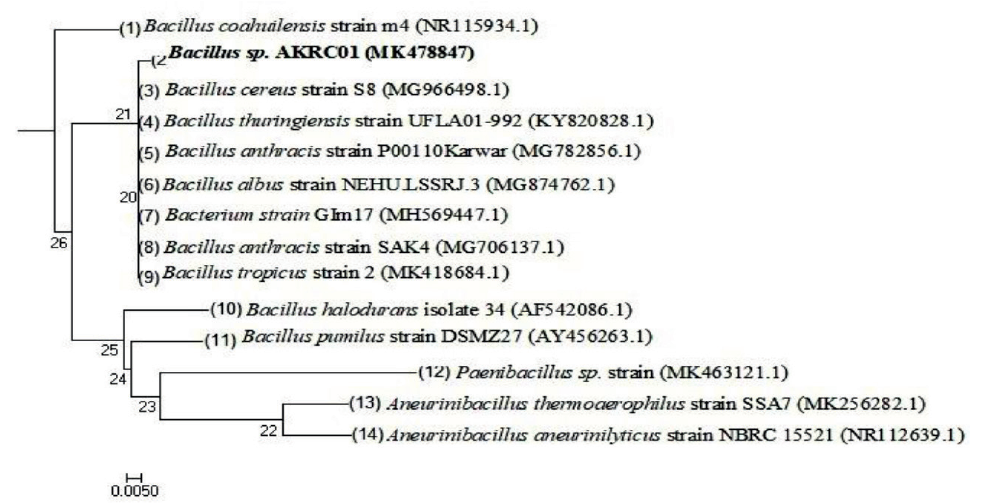
Fig. 2. Phylogenetic tree constructed to represent Bacillus sp. strain AKRC01